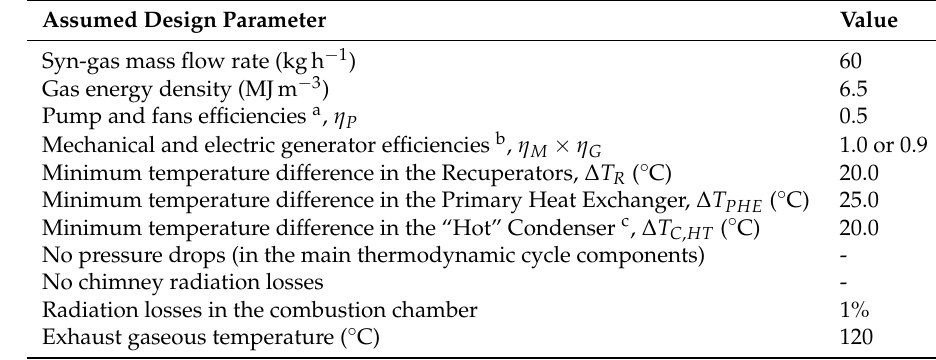
Table 2. The main assumptions for the power cycles